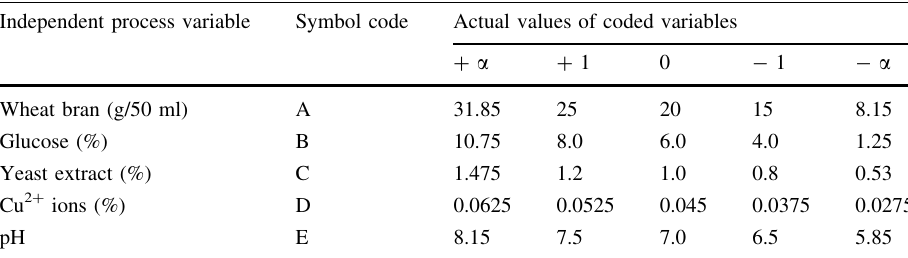
Table 2 Actual and coded level of independent variables tested with CCD-RSM design for laccase